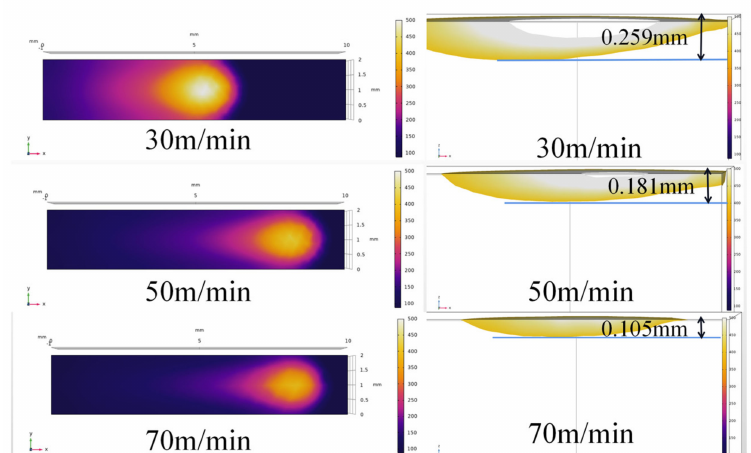
Figure 11. Depths of the heating layer at different cutting speeds.